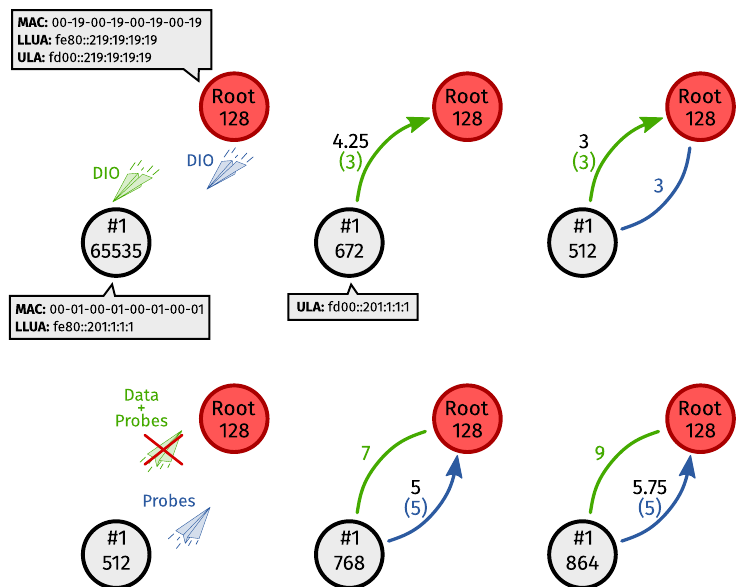
Figure 5. Operation example of the Dual-Radio interface RPL Objective Function (DRiPLOF). This figure should be viewed left to right and top to bottom. All nodes have a green and a blue interface. Inferred metrics are displayed in the same color as their corresponding interface; normalized metrics are written in black; the arrows indicate which interface is preferred. Note that I node = 2, IL max = 1, IL div = 4, and S =